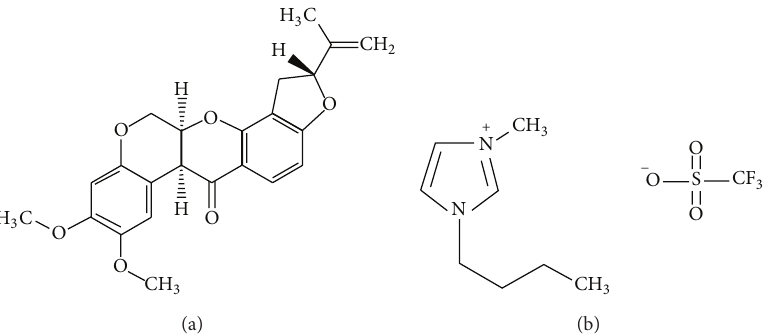
Figure 1: Molecular structure of (a) rotenone and (b) one of the selected ionic liquids: 1-butyl-3-methylimidazolium trifluoromethanesul- fonate, [BMIM]